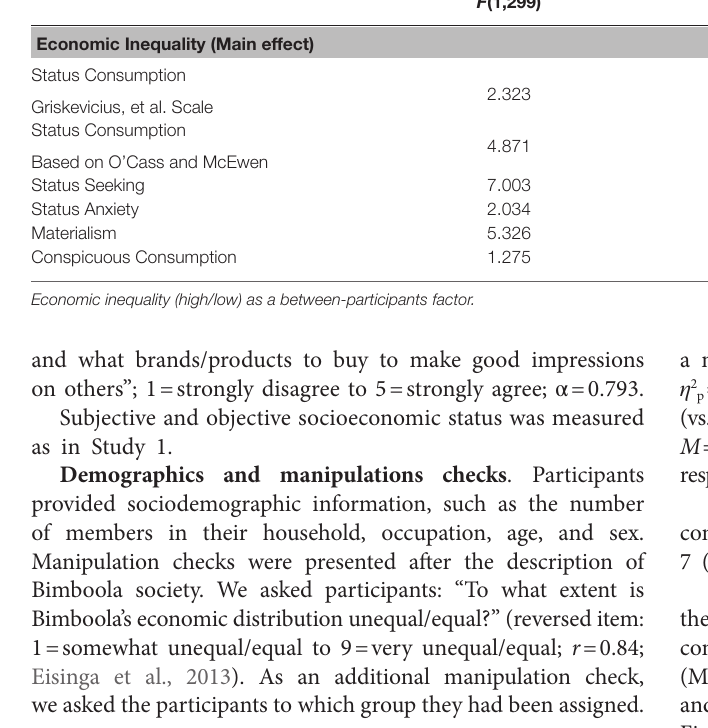
TABLE 4 | Multivariate analysis for the main effect of economic inequality (high/low) on variables included in Study 2. F (1,299) p η 2